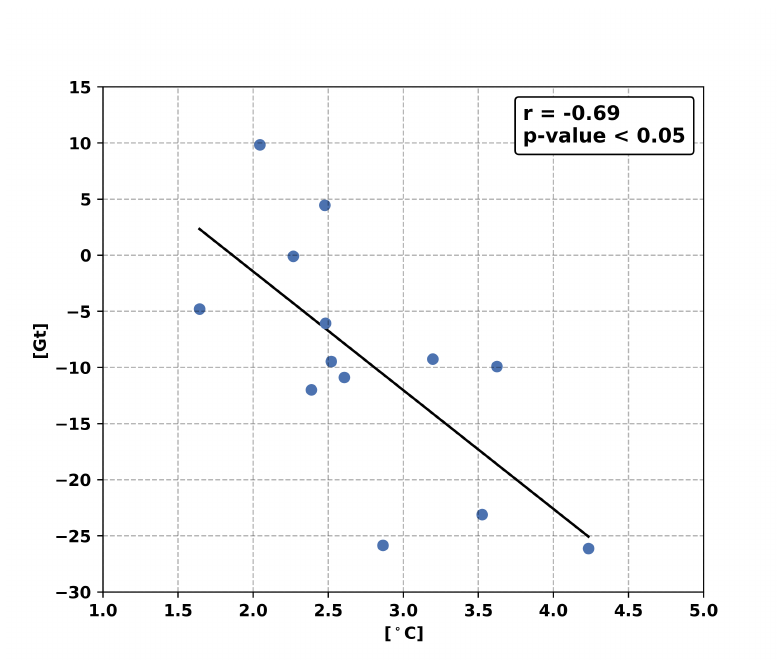
Figure 10. Comparison between mean summer temperature (JJA) from ERA-Interim and annual mass balance from GRACE for the time period